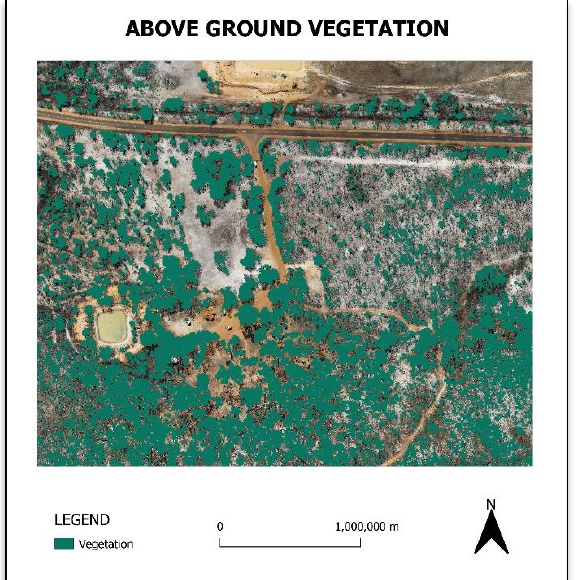
Figure 5. CHM output for identifying vegetated regions from non-vegetation over aerial imagery of the